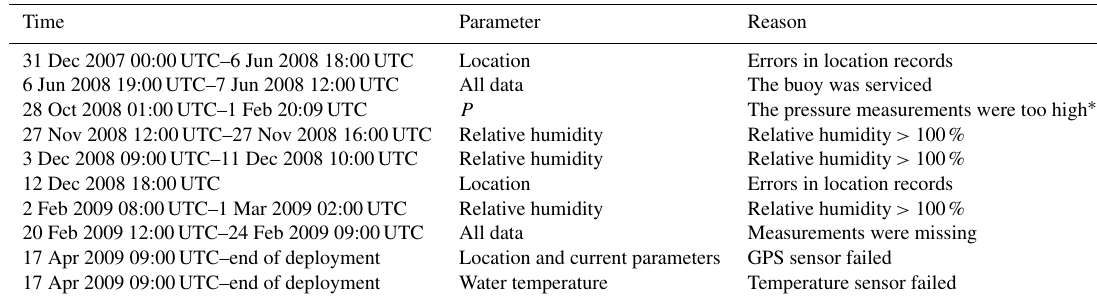
Table 3. List of periods where measurements are missing or clearly erroneous, parameters affected and